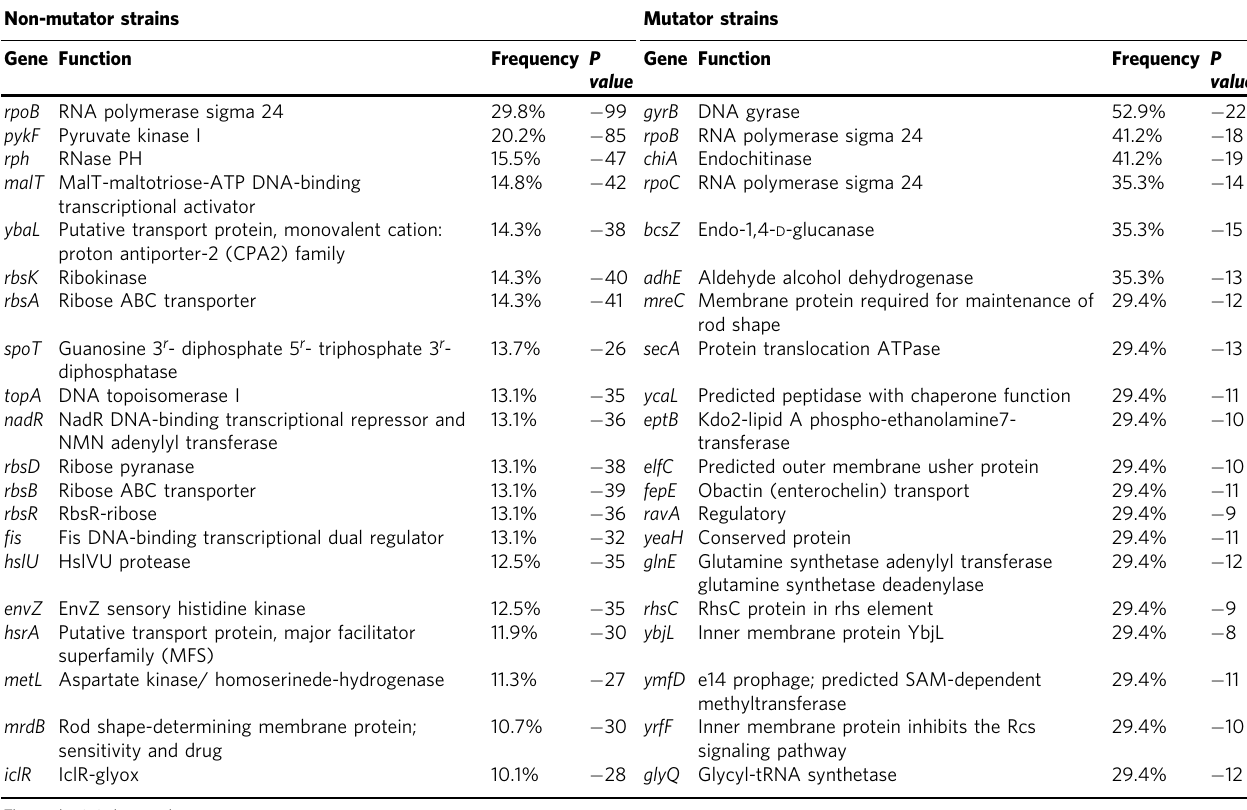
Table 1 The hotspot genes in non-mutator and mutator strains Non-mutator